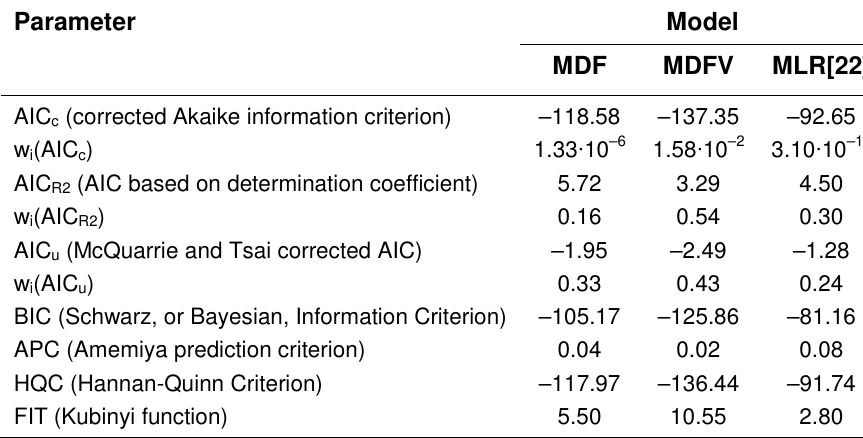
Validation and Comparison of the Models: Results of Parameters from Eqs. 1–8